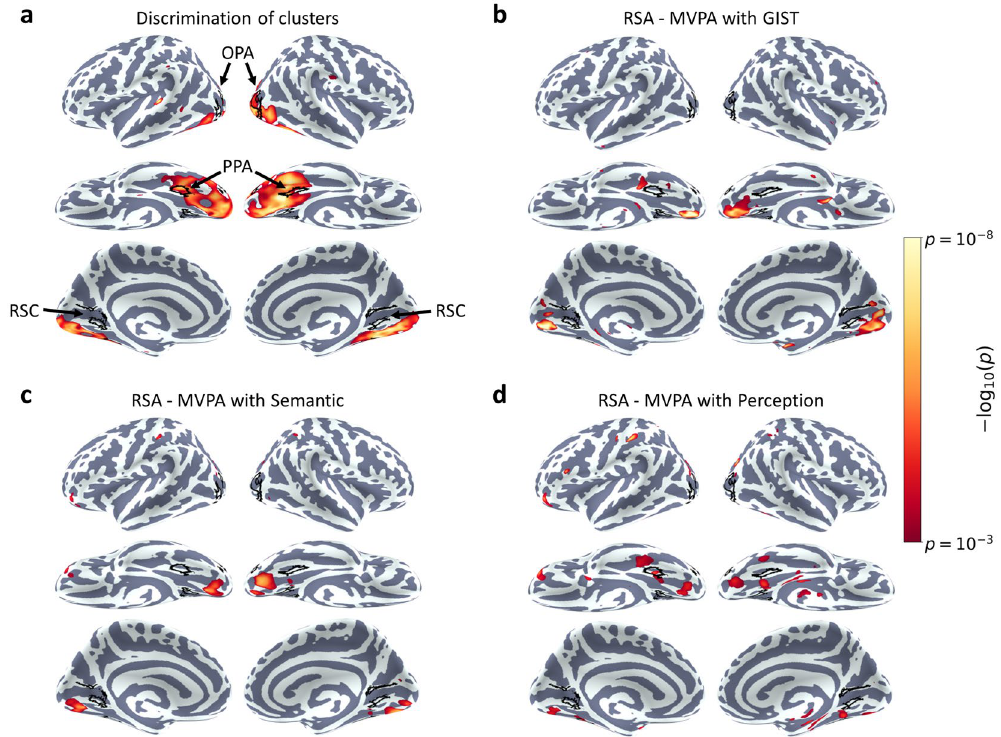
Figure 7. Searchlight analyses. ( a ) Discrimination of scene clusters, assessed by paired-samples t-tests contrasting within over between cluster correlations. ( b – d ) Results of representational similarity analyses between off-diagonal elements of the MVPA and ( b ) GIST, ( c ) semantic, and ( d ) perceptual models. In all cases the relevant test was run for each sphere separately, and the resulting p -value assigned to the central voxel of the sphere. These p -statistic maps are displayed on the Freesurfer average surface, thresholded at p < 0.001 (uncorrected). Locations of the main scene ROIs are also